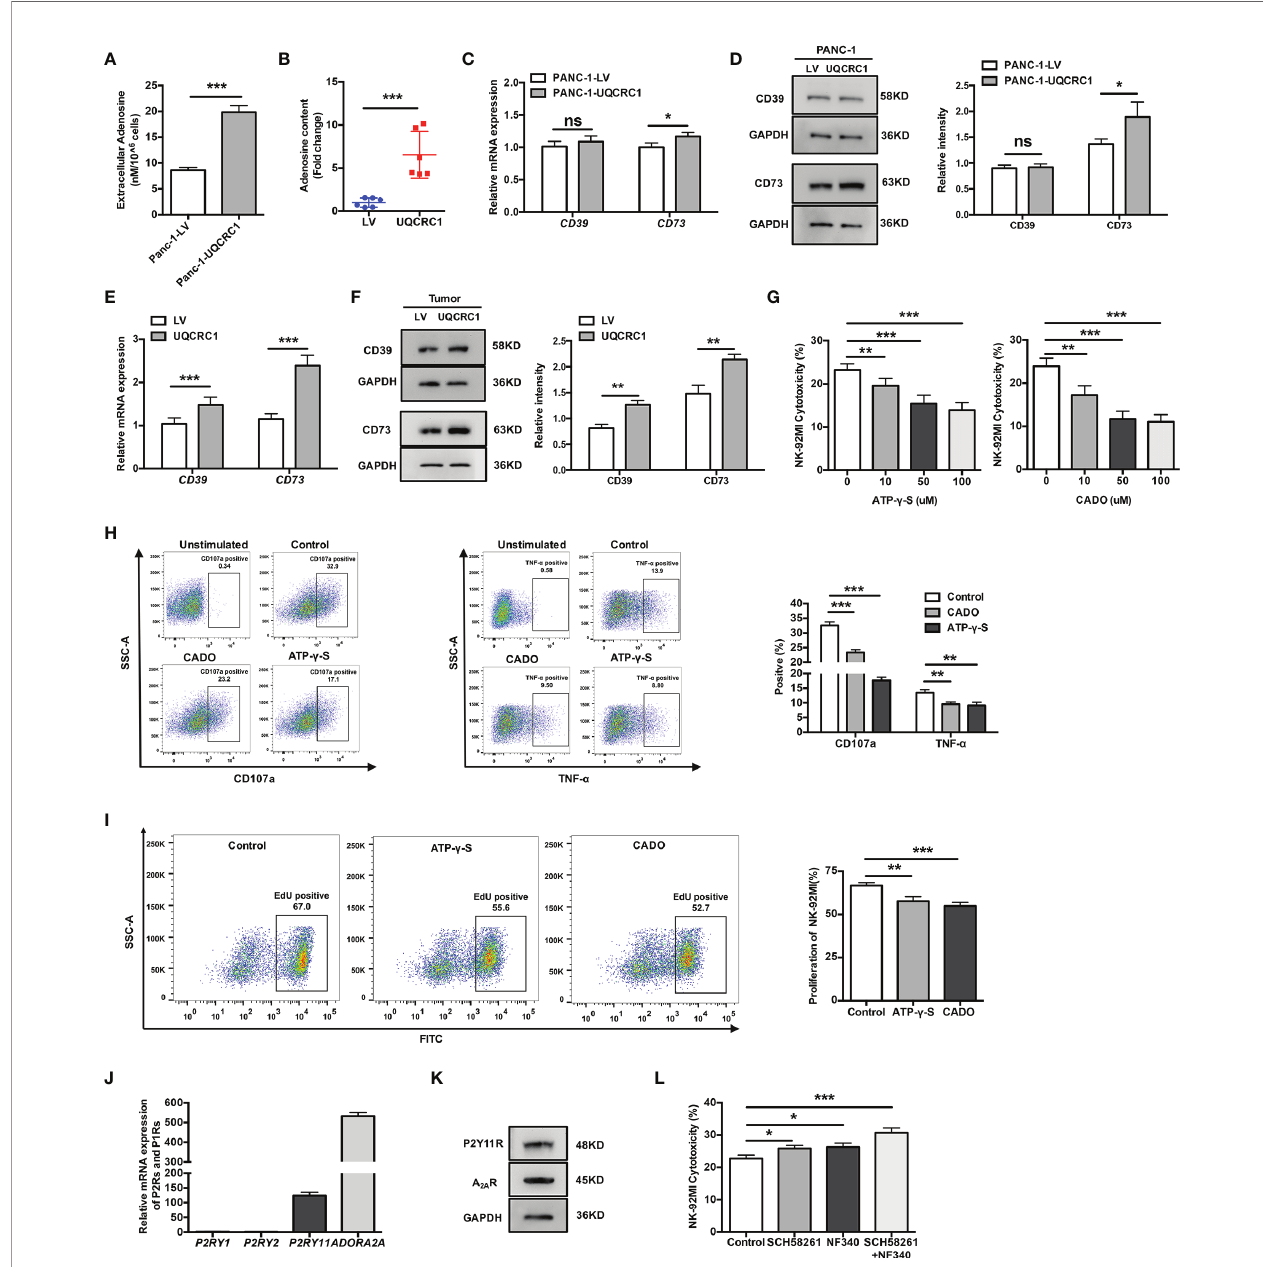
FIGURE 4 | ATP and its metabolite adenosine inhibit NK cells by engaging P2Y11R and A 2A R. (A) The Ado levels in the culture supernatant of UQCRC1- overexpressing and control PANC-1 cells. (B) The Ado content in UQCRC1-overexpressing and control PC subcutaneous xenografts. (C) The relative mRNA levels of CD39 and CD73 in UQCRC1-overexpressing and control PANC-1 cells. (D) The representative images of the protein levels of CD39 and CD73 in UQCRC1- overexpressing and control PANC-1 cells. (E) The relative mRNA levels of CD39 and CD73 in UQCRC1-overexpressing and control tumor xenografts. (F) The representative images of the protein levels of CD39 and CD73 in UQCRC1-overexpressing and control tumor xenografts. (G) The cytotoxicity of NK-92MI cells against parental PANC-1 cells in the presence of ATP- g -S or CADO. Before co-culture, the NK-92MI cells were pre-incubated with 100 m M ATP- g -S or 50 m M CADO for 3 h. (H) Representative fl ow cytometry plots and quanti fi cation of CD107a positive or TNF- a positive NK-92MI cells after co-culture with parental PANC-1 cells in the presence of ATP- g -S or CADO. Before co-culture, the NK-92MI cells were pretreated as above-mentioned. (I) The proliferation rate of NK-92MI cells after being treated with 100 m M ATP- g -S or 50 m M CADO for 24 h. (J) The relative mRNA expression of P2RY1 , P2RY2 , P2RY11 , and ADORA2A in NK-92MI cells. (K) The protein levels of P2Y11R and A 2A R in NK-92MI cells by Western Blot. (L) The cytotoxicity of NK-92MI cells toward UQCRC1-overexpressing PANC-1 cells. Before co-culture, the NK-92MI cells were pretreated with 1 m M SCH58261 and/or 10 m M NF340 for 30 min. All data are presented as the mean ± SD (n = 3 independent biological replicates). *, p < 0.05; **, p < 0.01; ***, p < 0.001; ns, not signi fi